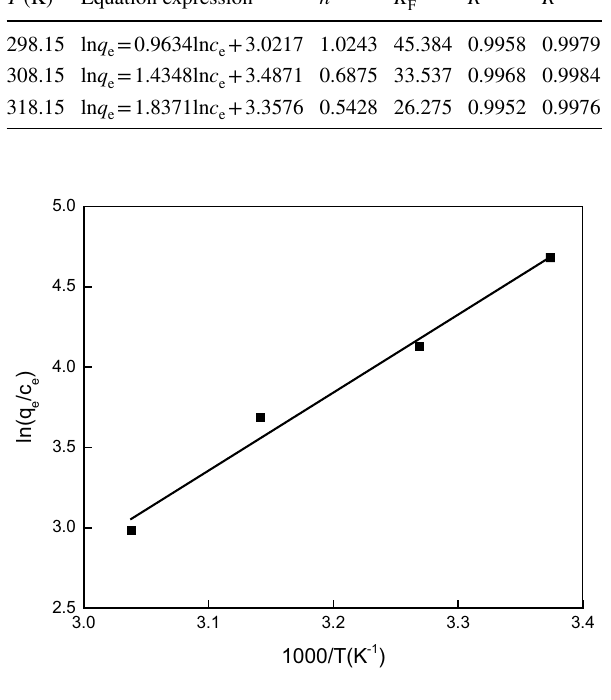
Table 4 Freundlich isothermal equation and data T (K) Equation expression